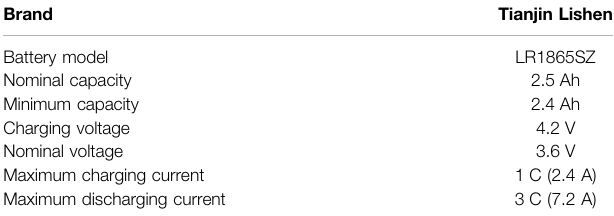
TABLE 1 | Detailed parameters of the used 18650 battery.